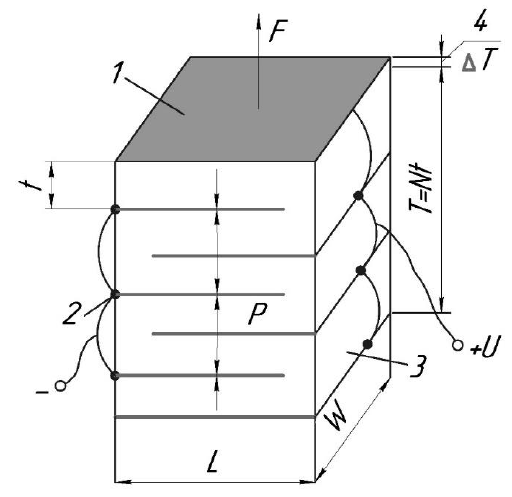
Figure 1. Scheme of piezo actuator consisting of piezo elements multilayer package: 1 – external electrode; 2 – internal electrodes; 3 – piezo material, 4 – piezo material